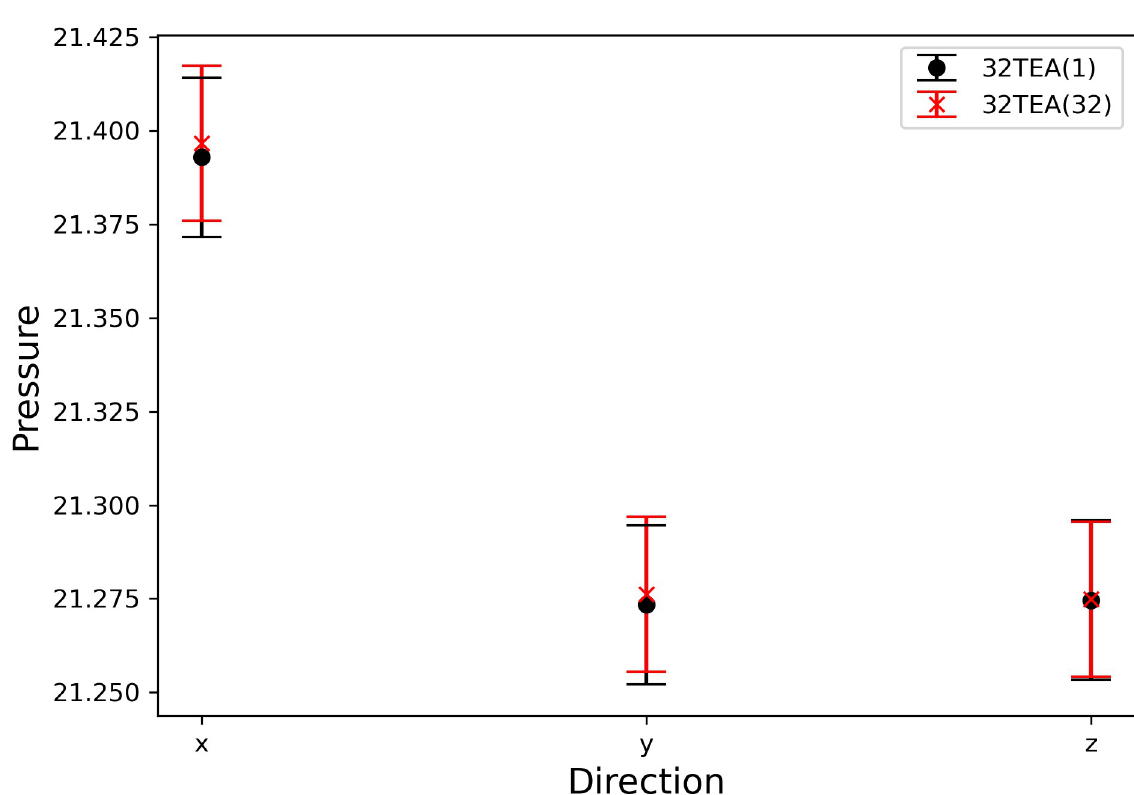
Fig 8. Pressure of the membrane system for each